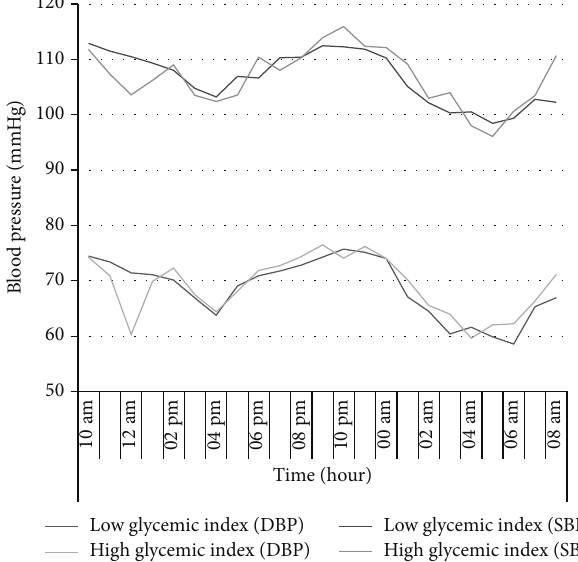
Figure 1: Constant SBP and DBP measurements in HGI and LGI groups at baseline and after the 24-hour interventions (values are expressed as mean ±